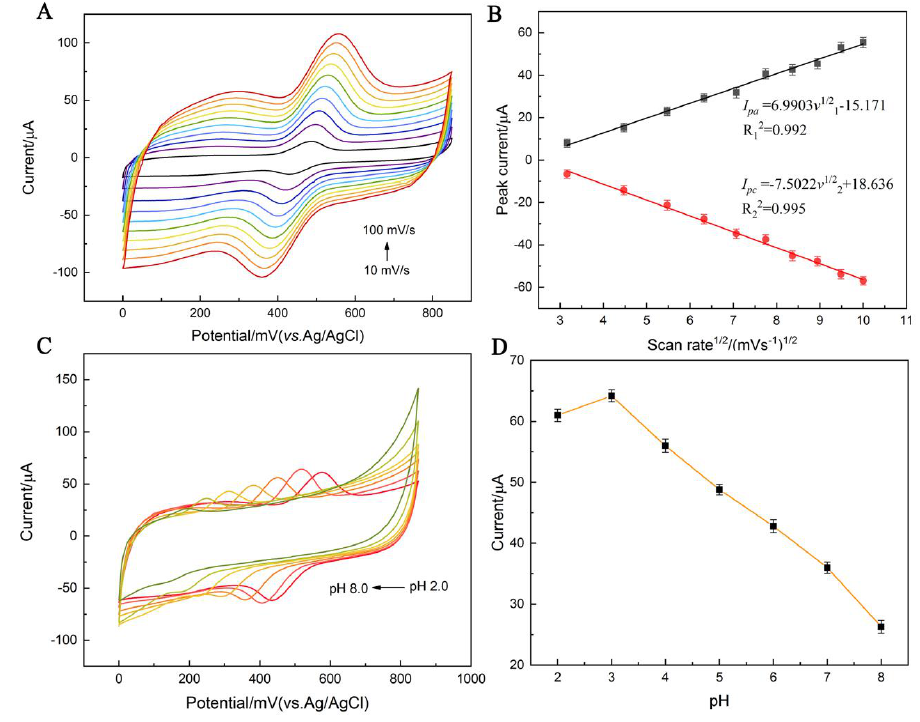
Figure 4. ( A ) CVs of the Au@Pt-PEI-RGO / GCE toward 0.5 mM chicoric acid in Na 2 HPO 4 -citric acid solution (pH 3) with different scanning rates (10, 20, 30, 40, 50, 60,70, 80, 90, and 100 mV s − 1 ). ( B ) Linear relationship of the redox peak current (I p ) versus the square root of scan rate (v 1/2 ). Error bars = ± standard deviation, n = 5. ( C ) CVs responses to 0.5 mM chicoric acid in different pH conditions of Na 2 HPO 4 -citric acid solution (pH 2, 3, 4, 5, 6, 7, and 8) with Au@Pt-PEI-RGO / GCE. ( D ) The linear relationship of the oxidation potential versus the pH. Error bars = ± standard deviation, n = 5.